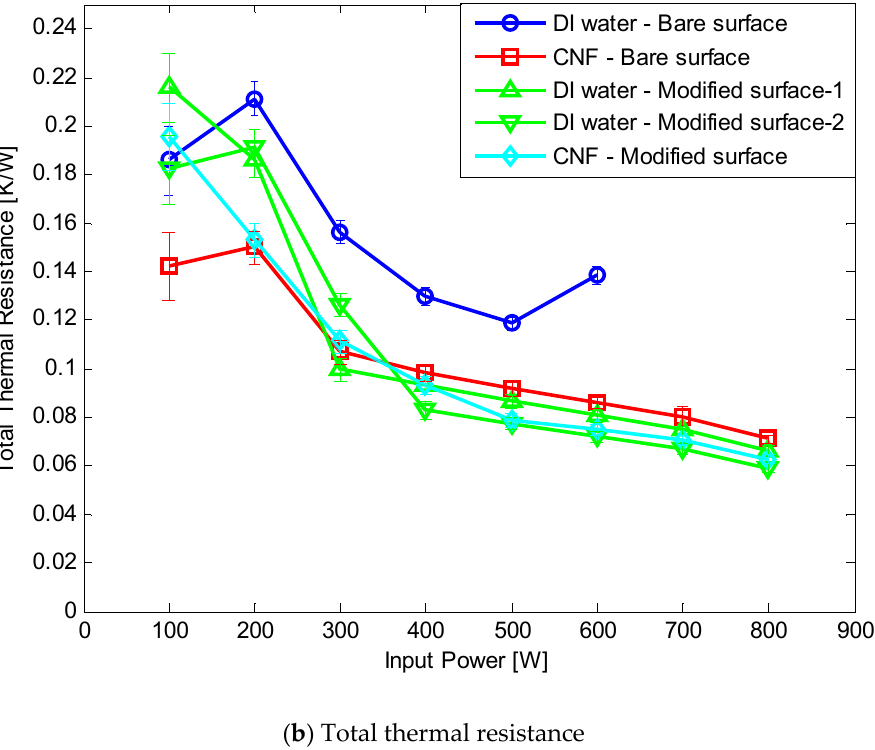
Figure 12. Comparison of the experimental results at FR 0.75. Figure 13 shows a comparison of the BHTC based on each variable. As shown, the higher the FR, the smaller the enhancement rate due to the surface modification. At low FRs, film evaporation was dominant. However, at high FRs, the ratio of pool boiling increased slightly due to the large amount of working fluid. Therefore, at low FRs, the inner surface was dry and then rewetted, and the hydrophilic surface rewetted faster than the bare surface. Meanwhile, the effect of surface modification was insignificant at high FRs.